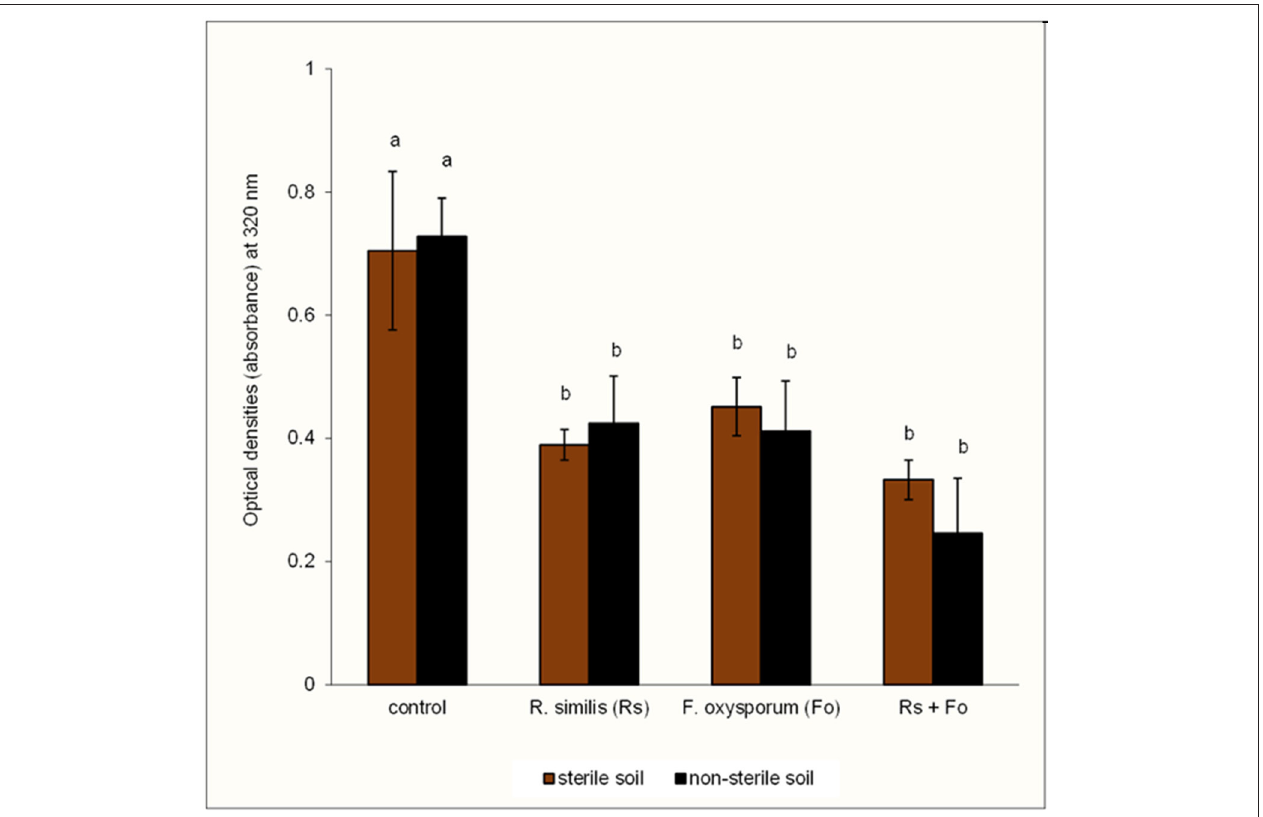
FIGURE 10 | Optical density of root extracts from potted tissue culture banana plants under independent or combined inoculation with Fusarium oxysporum V5w2 and Radopholus similis , and grown in either sterile soil or non-sterile soil supplied with complete nutrient solution. Bars with the same letter represent values that are not statistically different [ F (7,16) 14.79, p < =